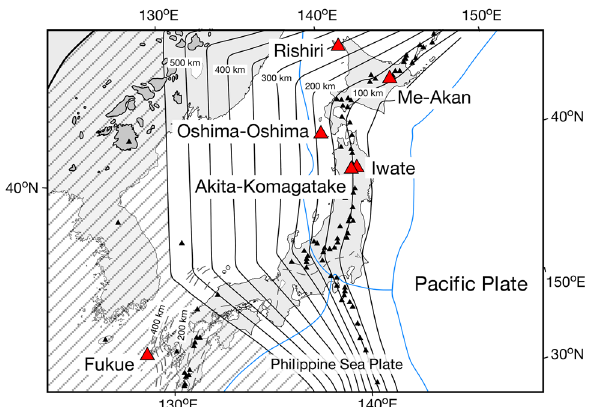
Figure 1. Map showing the distribution of active volcanoes above the subducted Pacific slab. The studied active volcanoes are shown here: Iwate ( Z = ~ 90 km), Akita-Komagatake ( Z = ~ 100 km), Me-Akan ( Z = ~ 110 km), Oshima-Oshima ( Z = ~ 180 km), Rishiri ( Z = ~ 300 km), and Fukue ( Z = ~ 550 km). The slab depths were sourced from Refs. 38,39 . The grey patches denote representative Cenozoic volcanic fields in China 40 . The solid and dashed contour lines denote the depths of the upper boundaries of the subducting Pacific and Philippine Sea slabs, respectively 39 . The blue lines denote the plate boundaries at the surface. The shaded area indicates the range of the stagnant Pacific slab at depths > ~ 550 km in the MTZ 41 . This figure was created using Canvas